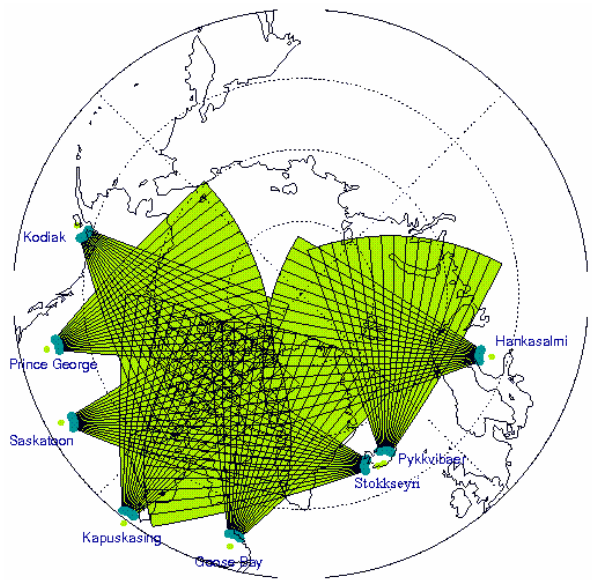
Figure 1 The schematic diagram of the fields of view of the SuperDARN radars used Fig. 1. The schematic diagram of the fields-of-view of the Super- in this paper. The inner range interval where the meteor echoes are detected is DARN radars used in this paper. The inner range interval where indicated by the overlapping dark green circles at the beginning of each radar field of the meteor echoes are detected is indicated by the overlapping dark view. green circles at the beginning of each radar field-of-view.